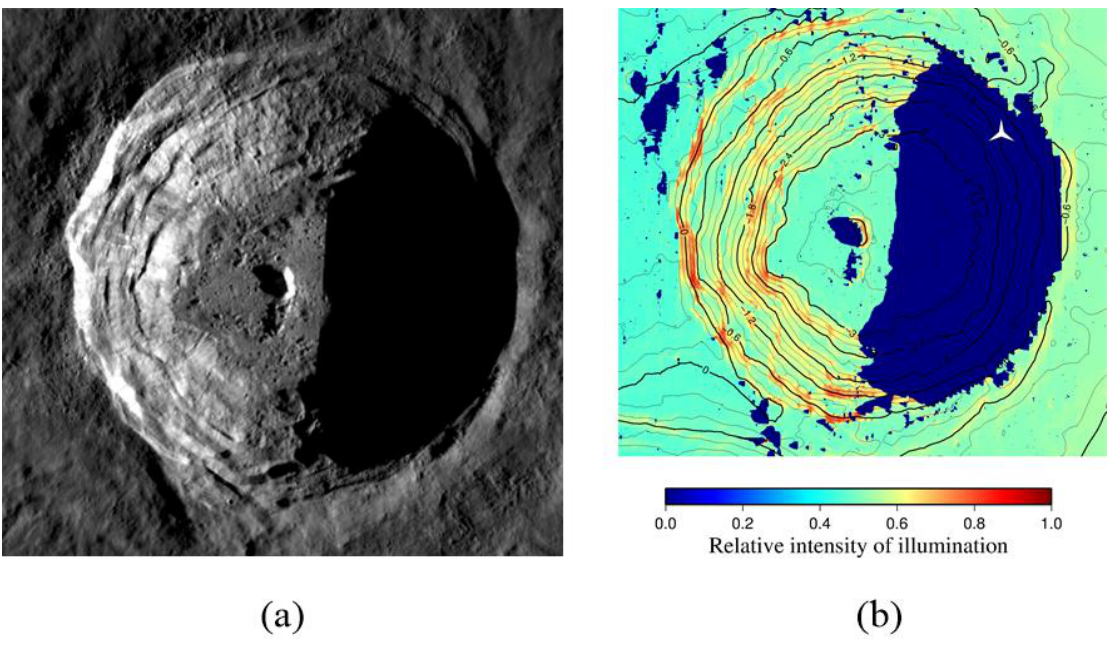
Figure 3. Comparison of illumination condition over Aristarchus crater. ( a ) comes from the narrow-angle camera (NAC) image (http://lroc.sese.asu.edu/posts/291) with a subsolar point longitude 34.0°E and ( b ) is computed from our illumination program. It is noted that minor differences caused by the limited resolution of digital elevation model exists between the observed ( a ) and modeled illumination distribution ( b ). The white three-star denotes the point (313°E, 24°N) used to test terrain obscuration at three lunar local time.